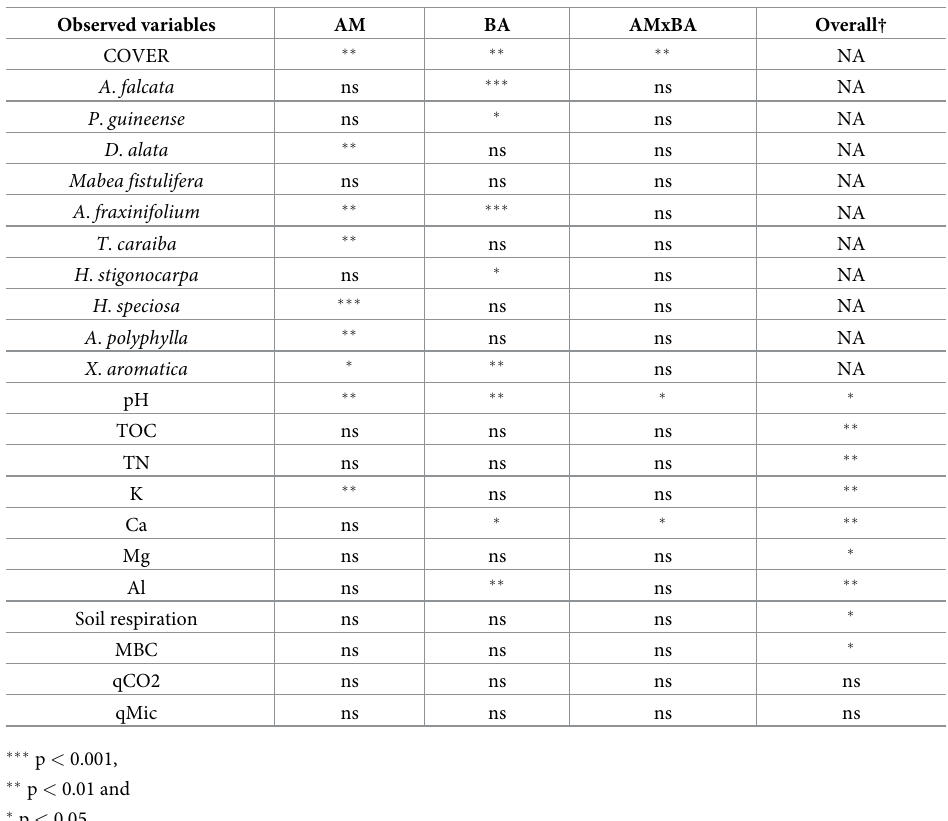
Table 1. Main and interactive effects of aquatic macrophyte (AM) residue, sugar cane bagasse ash (BA), their interaction (AMxBA), and of the three studied areas—Degraded area without intervention (DAWI), recovery management treatments (RM) and undisturbed Cerrado (CER), on vegetation, soil chemistry, and microbe- related soil properties. Observed